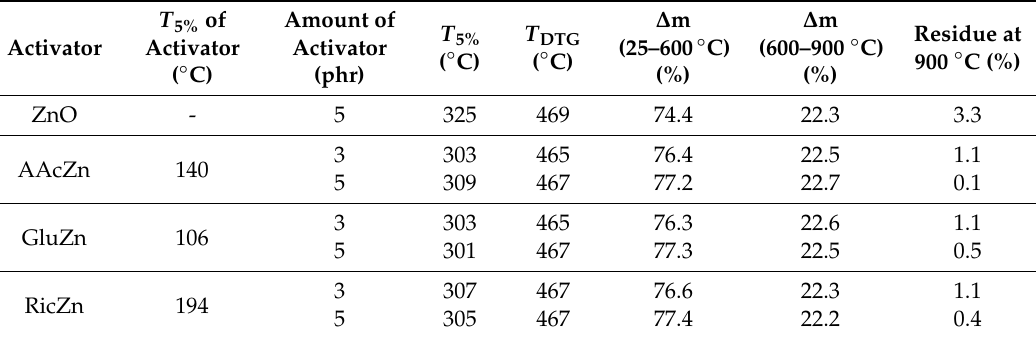
Table 7. Decomposition temperature at 5% ( T 5% ) mass change, di ff erential thermogravimetric (DTG) peak temperature ( T DTG ), and total mass loss ( ∆ m) during thermal decomposition of SBR